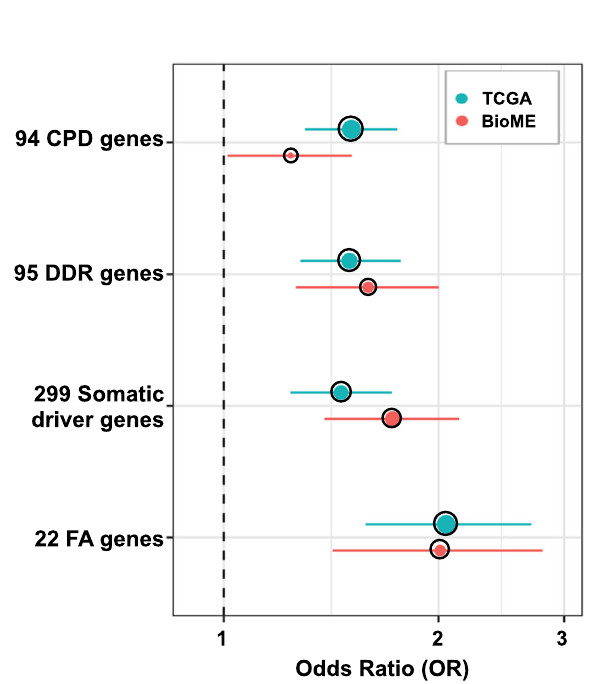
Fig. 3 Gene-set level rare, deleterious variant (RDV) burden in the discovery (blue) and validation (red) cohorts. The whiskers span the 95% con fi dence interval for OR values (penalized logistic regression). The black circle outline indicates signi fi cant burden p ≤